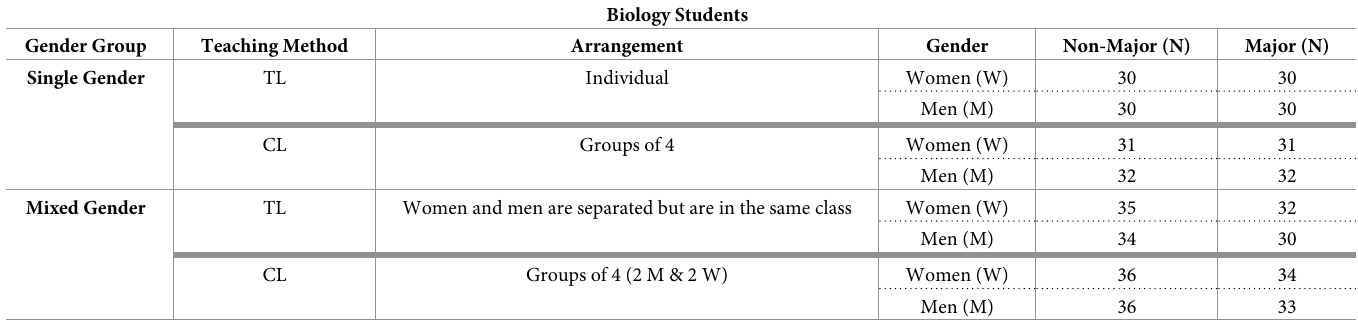
Biology Students